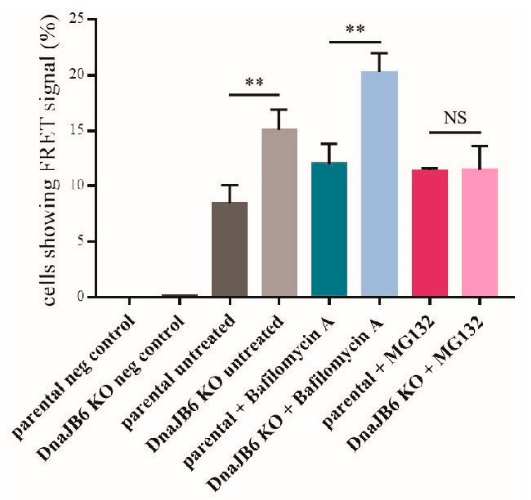
Figure 5. The α -Syn PFF-induced aggregation of α -Syn following lysosomal or proteasomal inhibitor treatment in α -Syn CFP / YFP HEK293 cells analyzed by FRET. Quantification of the percentage of alive and single α -Syn FRET HEK293 cells producing a FRET signal, as detected by BD LSRFortessa ™ . The cells had been transfected with 10 nM α -Syn PFFs for 48 h, and were treated (or not) with 100 nM bafilomycin A for 2 h or 25 µ M MG132 for 2 h. The data were analyzed by the Student’s t -test and are represented as mean ± SD: ns p > 0.05 * p < 0.05; ** p < 0.01 ( n = 3); 0.0; 0.1; 8.4 ± 0.95; 15.1 ± 1.06; 12 ± 1.05; 20.3 ± 0.984; 11.4 ± 0.145; 11.5 ± 1.24).